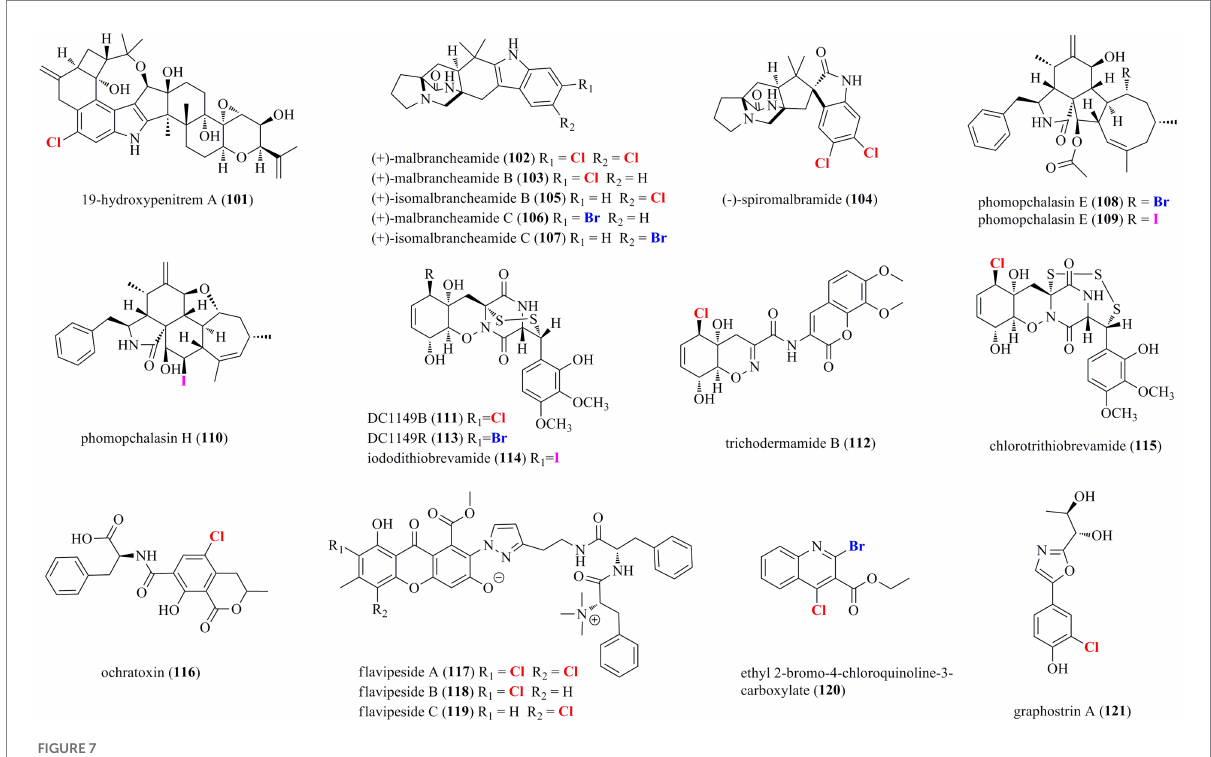
FIGURE 7 Halogenated alkaloids from marine-derived fungi ( 101–121